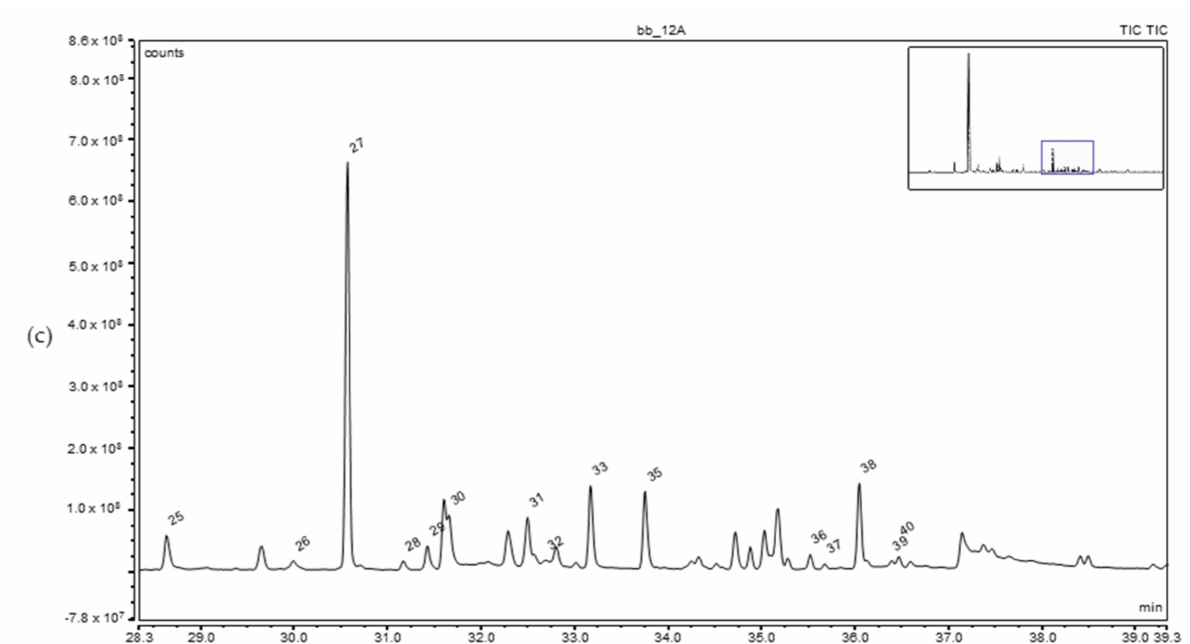
Figure A4. Total ion chromatogram of volatile analysis with HS-SPME-GC-MS from enzymatically extracted oil (Al- calase, 35 min) from by-products of Baltic herring. ( a ) Total ion chromatogram, ( b ) chromatogram scaled to reten- tion time 16.8–27.8 min and ( c ) chromatogram scaled to retention time 28.3–39.3 min. The numbered volatiles are (1) acetaldehyde, (2) 2-propenal, (3) propanal, (4) butanal, (5) 2,3-butanedione, (6) unknown 1, (7) formic acid, (8) 1,3- butanediol, (9) acetic acid, (10) 3-methylbutanal, (11) heptane, (12) 2-methylbutanal, (13) ( Z )-2-butenal, (14)